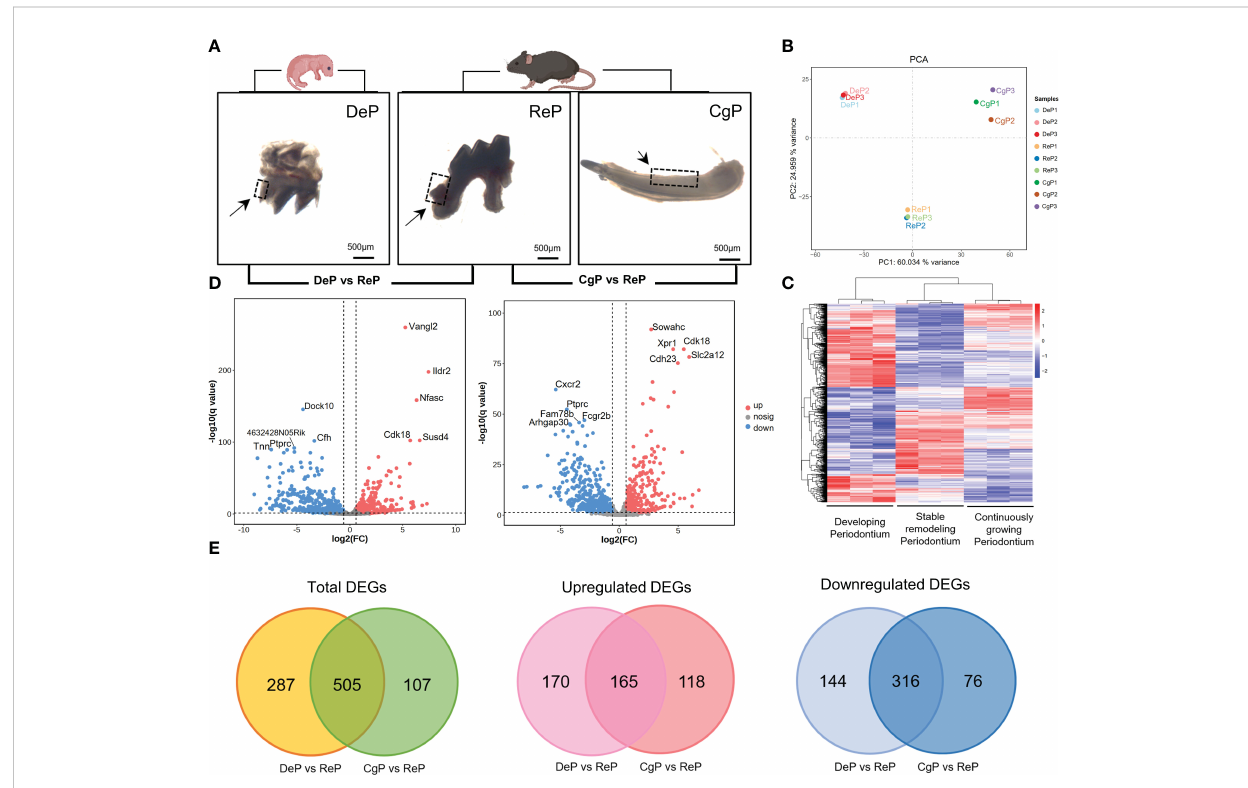
FIGURE 2 Comprehensive analysis of DEGs. (A) Postnatal mice dental follicles, adult mice incisors, and molars periodontal tissues were obtained. Tissues were collected around the tooth germ/tooth(inside the black dotted line). (B) Principal component analysis of the three groups. The higher the variation in gene expression patterns across samples was, the greater the distance among samples. (C) Heat map of differential gene expression levels in different periodontal tissues. The color saturation in the heat map indicates the expression of genes. Blue shows the lowest expression of genes, and red indicates the highest expression of genes. (D) Comparison of DEGs in DeP/CgP versus ReP using the Volcano plot. Red dots indicate signi fi cantly upregulated genes, blue dots indicate downregulated genes considerably, and gray dots represent nonsigni fi cantly differentially expressed genes. (E) Venn diagram. DEGs were identi fi ed as having a q value (adjusted p-value) of < 0.05 and |fold change| of ≥